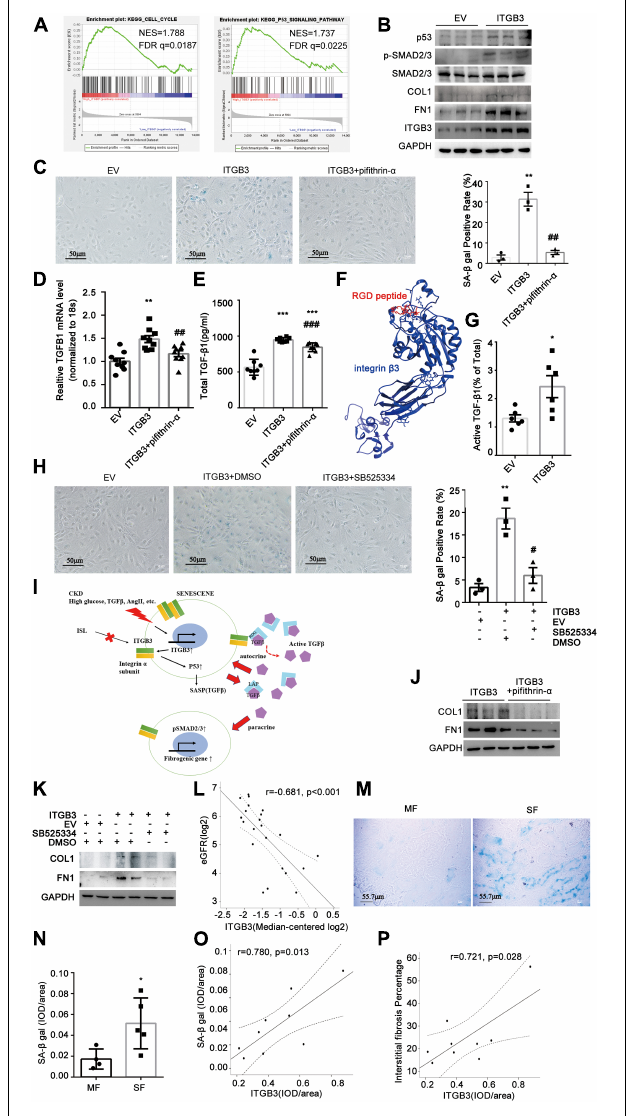
FIGURE 4 | Integrin β 3 (ITGB3) aggravated cellular senescence by upregulating p53 signaling pathway and TGF- β secretion. (A) GSEA revealed that cell cycle- and p53 signaling pathway-related biological functions were enriched in response to high ITGB3 expression based on the public GSE30529 dataset. (B) Expression of ITGB3, p53, SMAD2/3, p-SMAD2/3, COL, and FN1 in cells transfected with ITGB3 or EV. (C) Senescence induced upon ITGB3 is shown by an increase in the percentage of cells staining positive for SA- β -gal activity. Senescence induced by ITGB3 could be reversed by pifithrin- α (20 µ M, 24 h). Quantification of three independent experiments is shown. (D) The mRNA levels of TGFB1 were increased in